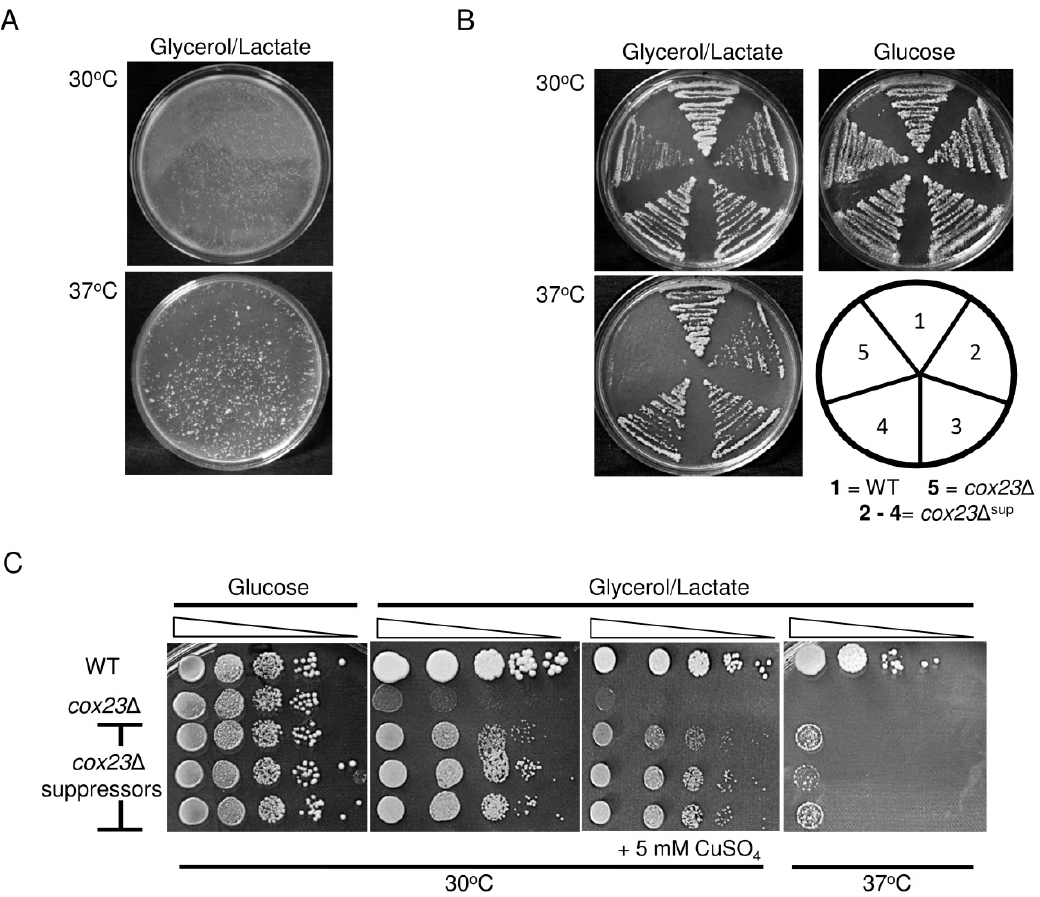
FIGURE 1: Growth properties of cox23 Δ suppressors. (A) Diploid cox23 Δ yeast cells were plated at a density of ~10 7 cells/plate on YP glyc- erol/lactate (YPGL). The plates were photographed after 8 days of incubation at 30 and 37°C. (B) BY4743, cox23 Δ, and cox23 Δ suppressor cells were streaked on YPGL or YP-glucose (YPD) and incubated at the indicated temperatures. (C) Serial dilutions of BY4743, cox23 Δ, and cox23 Δ suppressors spotted on YPD or YPGL plates and incubated at 30°C for 2 and 5 days and at 37°C for 7 days, respectively (left most lane is OD 600 =